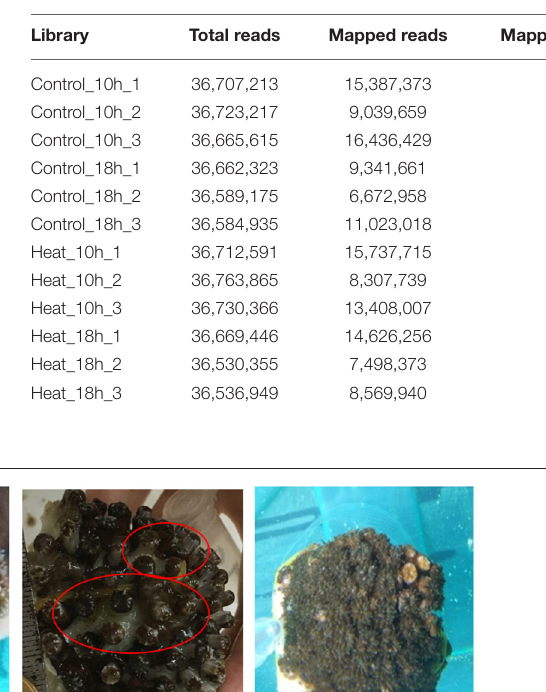
TABLE 1 | Transcriptome mapping statistics in coral Galaxea fascicularis .